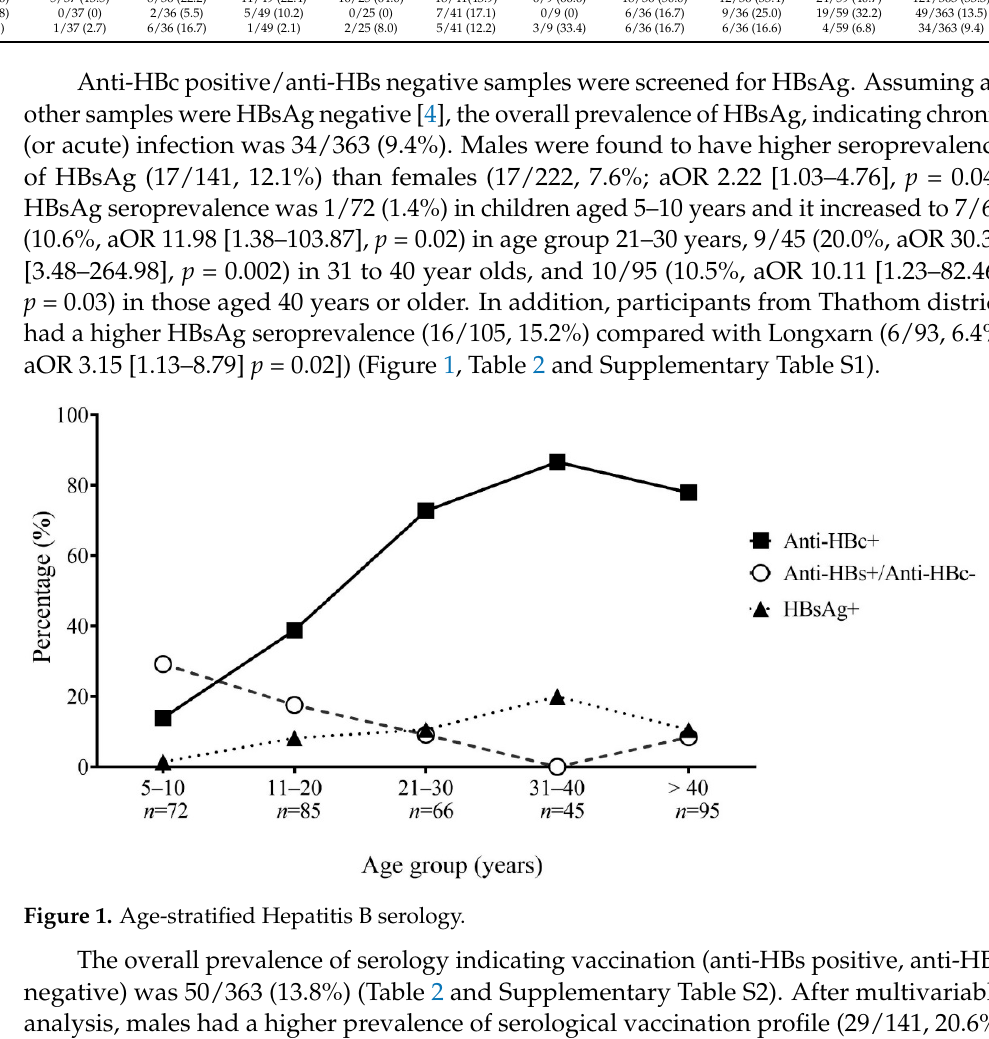
Table 2. Hepatitis B virus serology by age group and sex. Anti-HBc positive/anti-HBs negative sam- ples were screened for HBsAg. All other samples were assumed to be HBsAg negative [4].